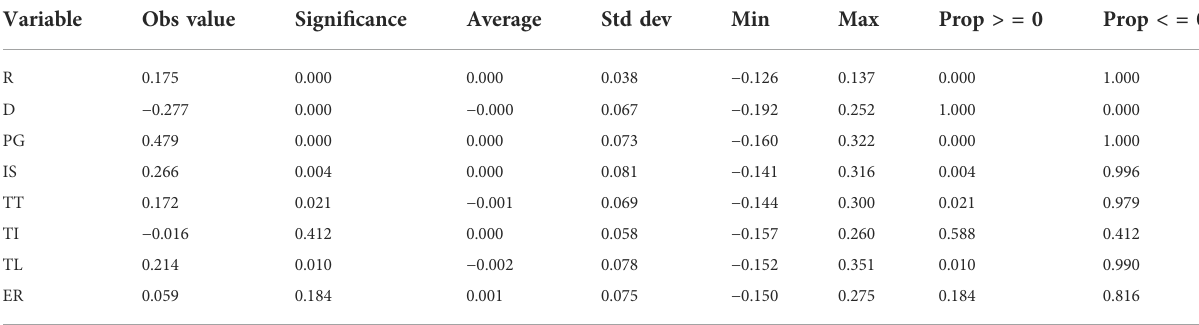
TABLE 6 The results of QAP association analysis.